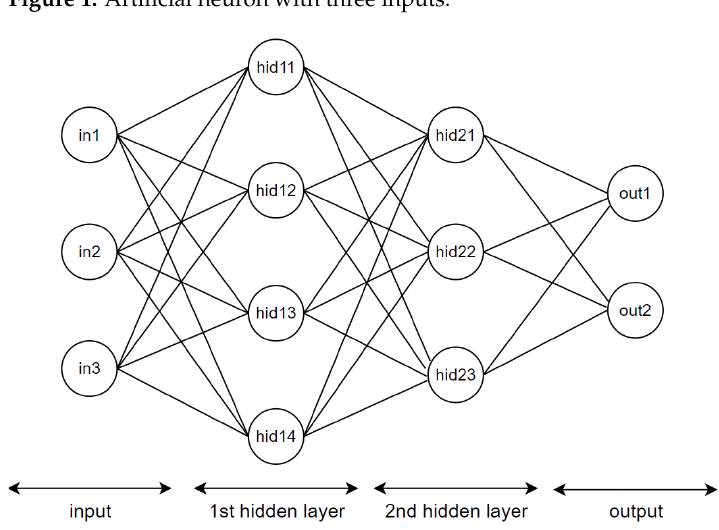
Figure 2. Feedforward neural network with two hidden